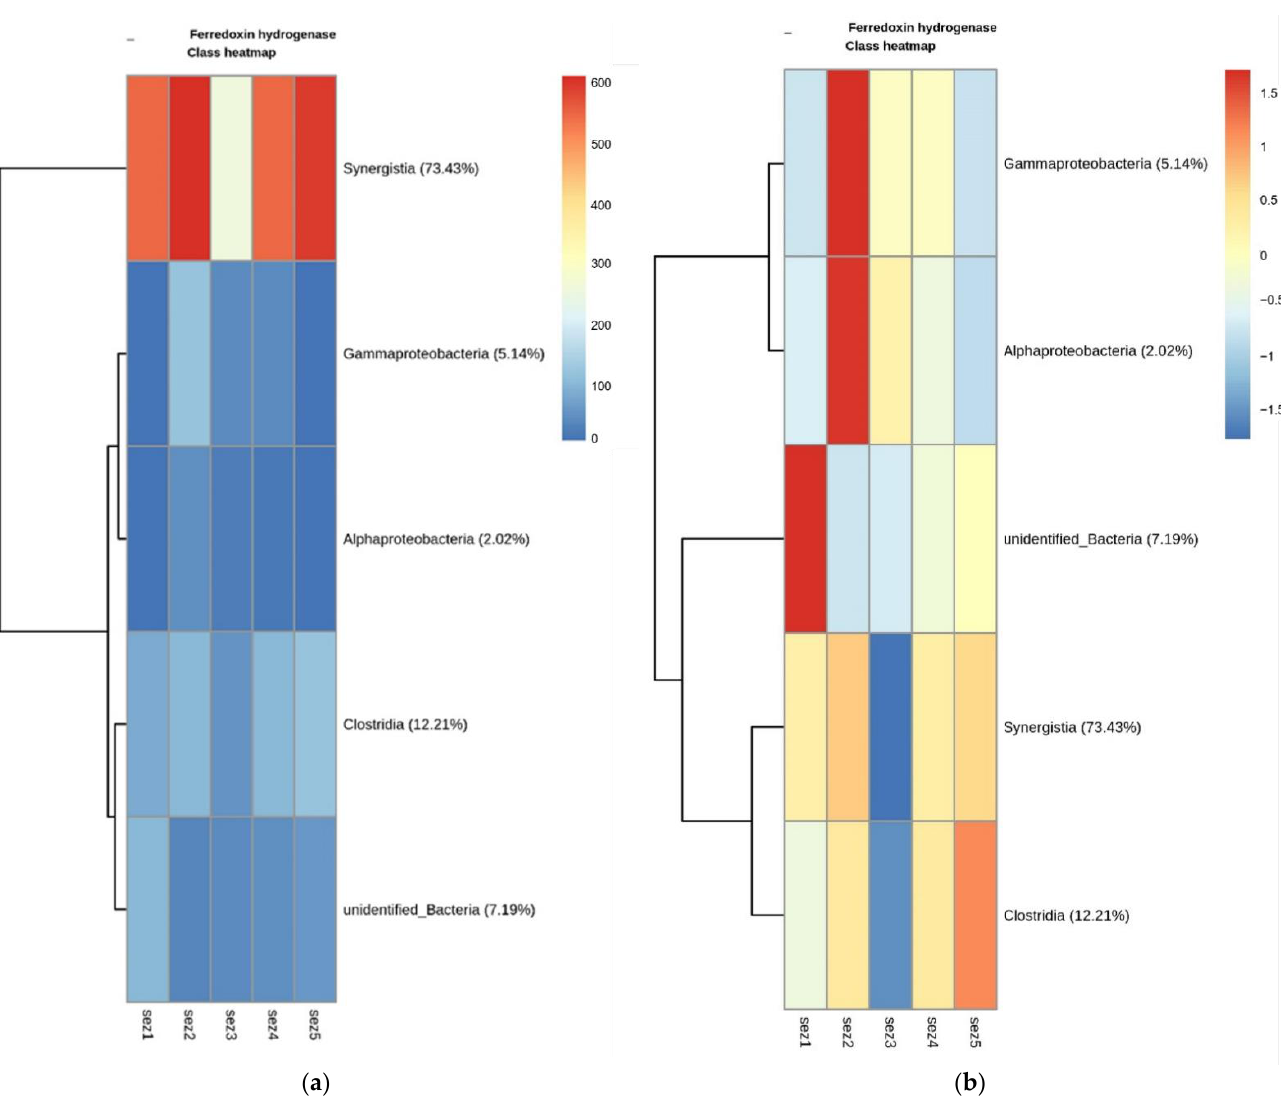
Figure A7. Functional heatmaps of ferredoxin hydrogenase: ( a ) absolute counts and ( b ) autoscaled counts, aggregated at the class level.